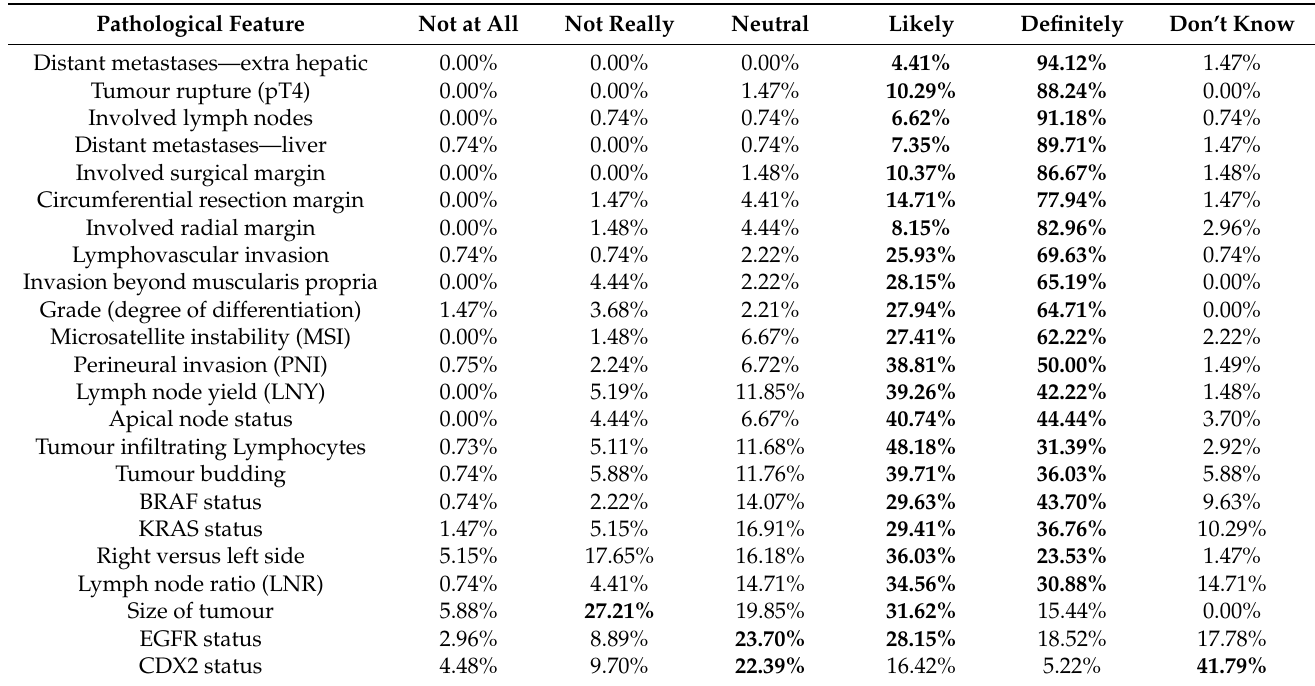
Table 1. Likert score table for specialist responses to whether pathological feature influence prog- nostication. Adapted from Wiley Cancer Reports—Toh et al. (2020) [8] under the creative commons attribution license (CC BY).